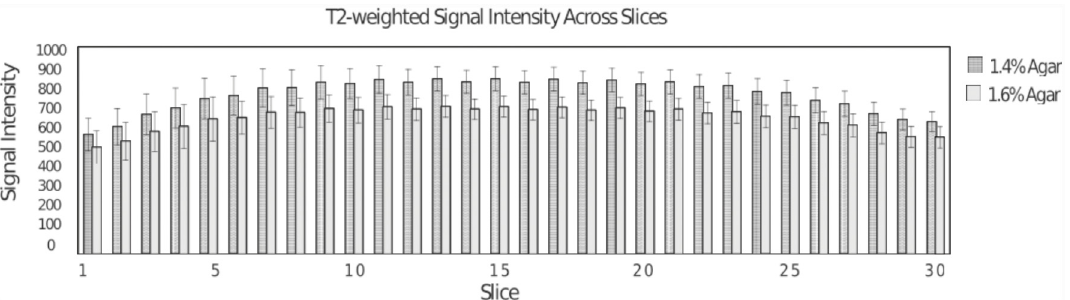
Fig 3. Signal behavior within and across slices from TSE scan (TE = 154 ms). For each slice, the mean value for the 1.4% agar compartment is slightly higher than that for the 1.6% agar concentration as expected. The signal behavior reflects the coil sensitivity as well as the phantom uniformity.